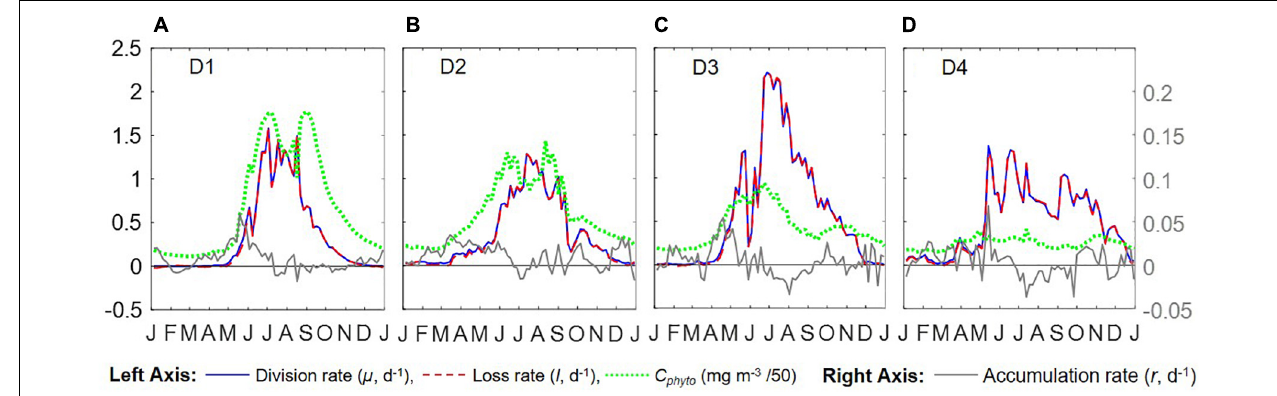
FIGURE 6 | Seasonal climatologies of C phyto , µ , l , and r from Argo floats for all 4 regions (panels (A–D) represent regions D1–D4). Unit for µ , l , and r is d − 1 .